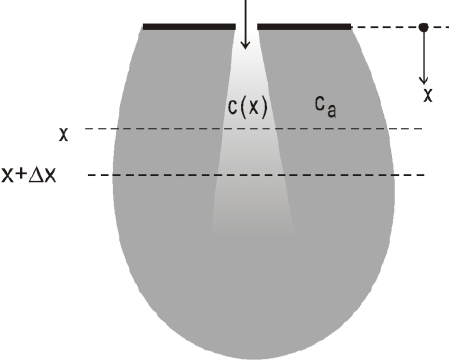
Figure 3. Schematic representation of jet with clean air is supplied into an ambient with uniform concentration (courtesy of Professor Mats Sandberg).